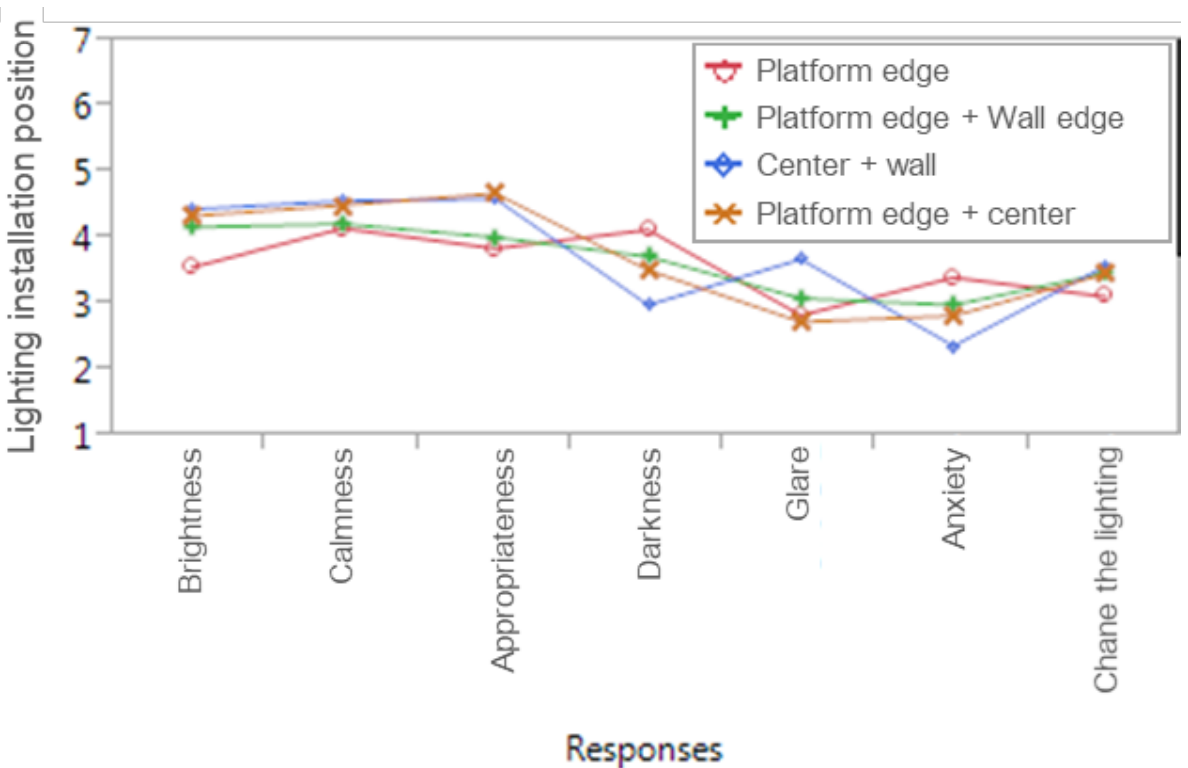
Figure 18. Significant difference depending on the lighting method.